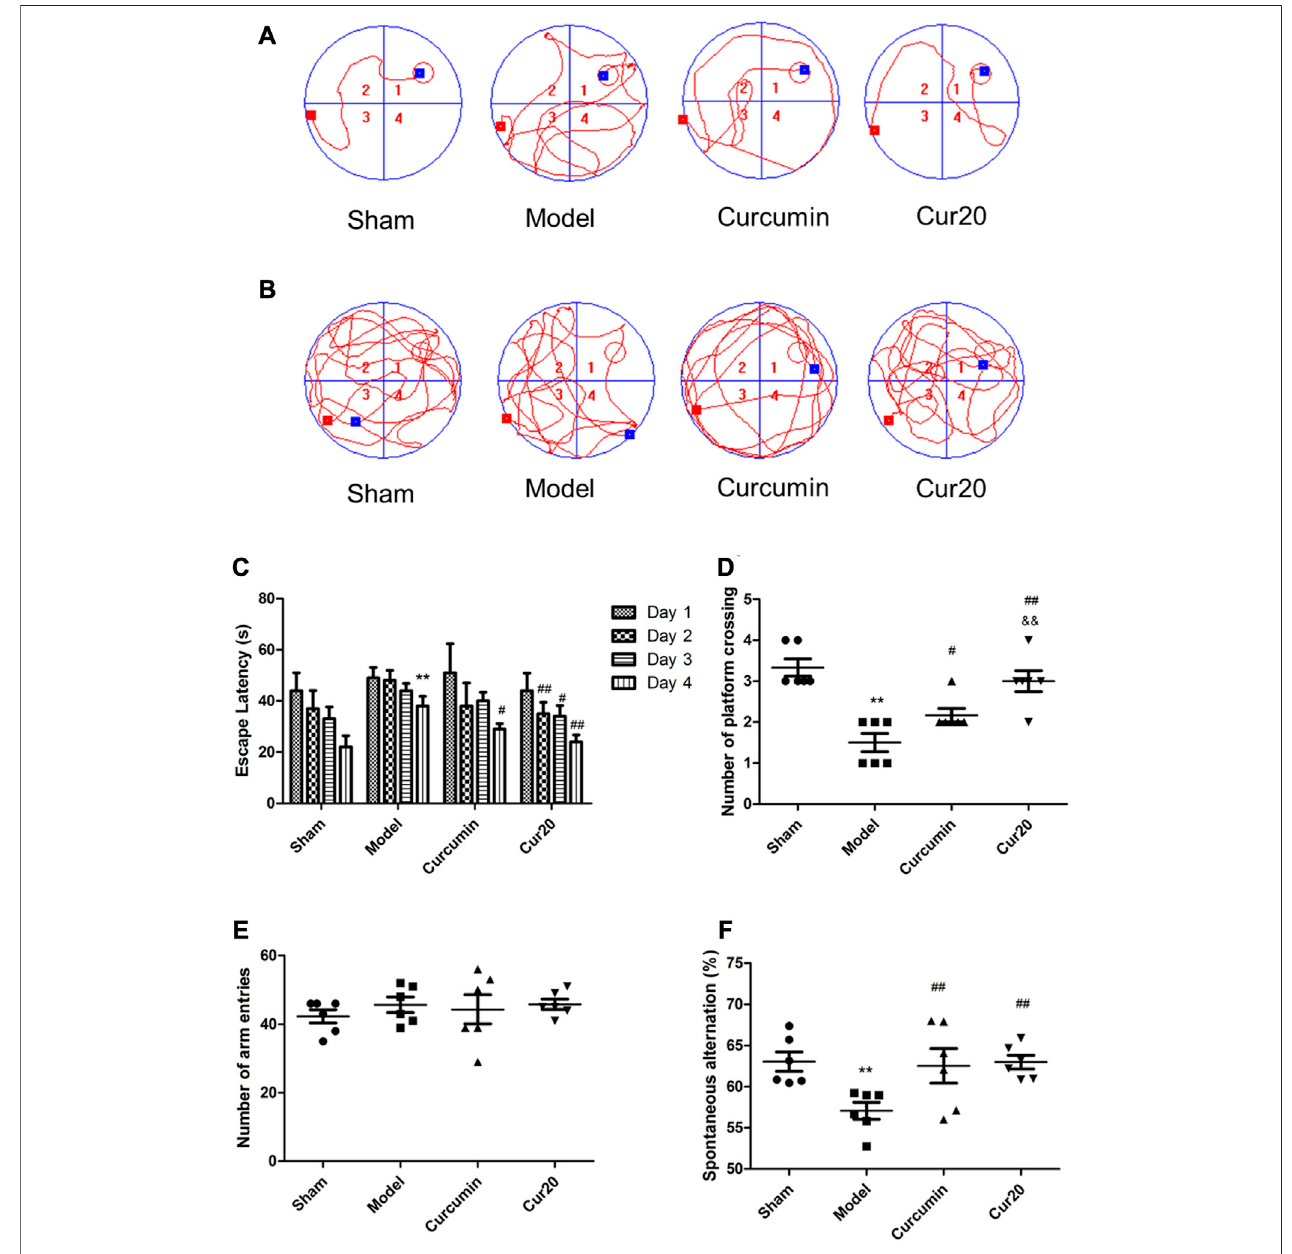
FIGURE4| EffectofCur20onthelearningmemory (A – D) andworkingmemory (E,F) ofVascularDementiamodel.a,Representativepathwaysonthefourthdayof navigation test; B , Representative swim paths on the fi fth day of probe test; C , Escape latencies of mice during acquisition phase; D , Number of platform crossings of mice within 90s in probe test. E , The number of mice enter the three arms in the Y maze; F , Spontaneous alternation rate of mice. ** p < 0.01 vs. control group ； ## p < 0.01 vs. Model group; && p < 0.01 vs. Curcumin group.